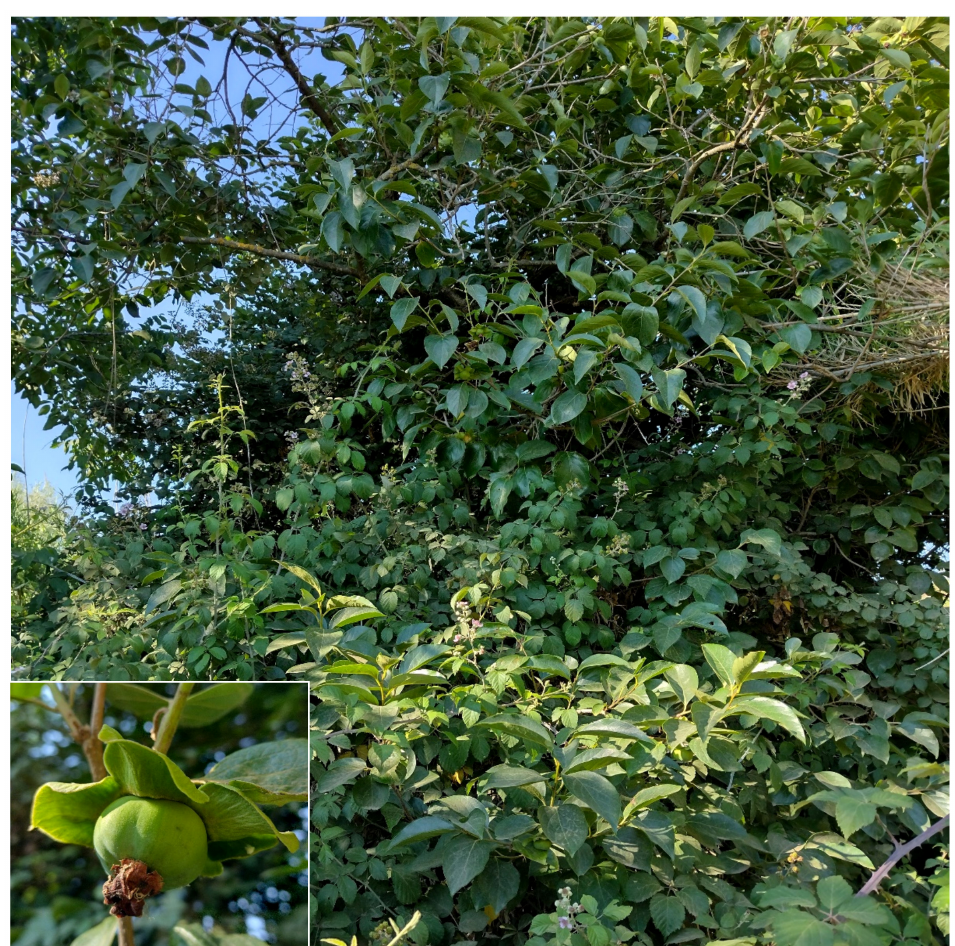
Figure 60. Diospyrus kaki along a channel in Caffarella valley.